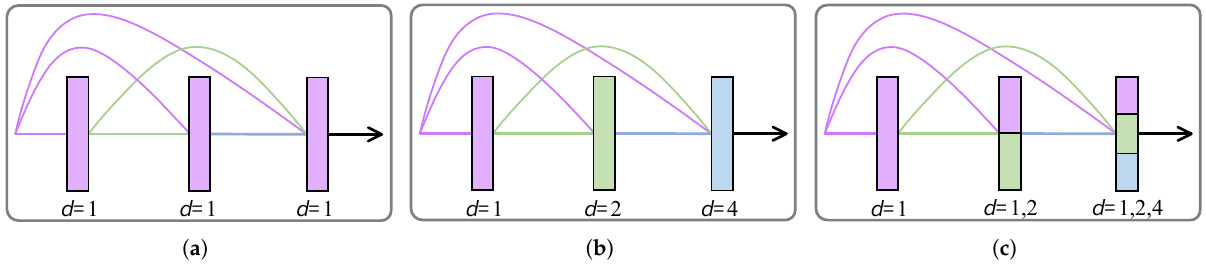
Figure 3. The structures of three different blocks. ( a ) Densely naive convolutional block. ( b ) Densely naive dilated convolutional block. ( c ) Densely pyramidal dilated convolutional